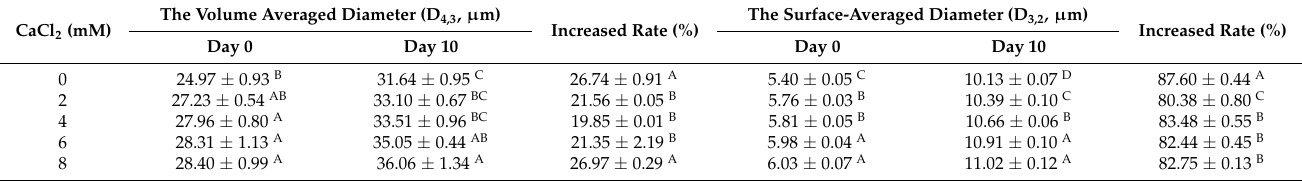
Table 1. Droplet size of filled hydrogels containing different CaCl 2 levels for fixed storage times (0 and 10